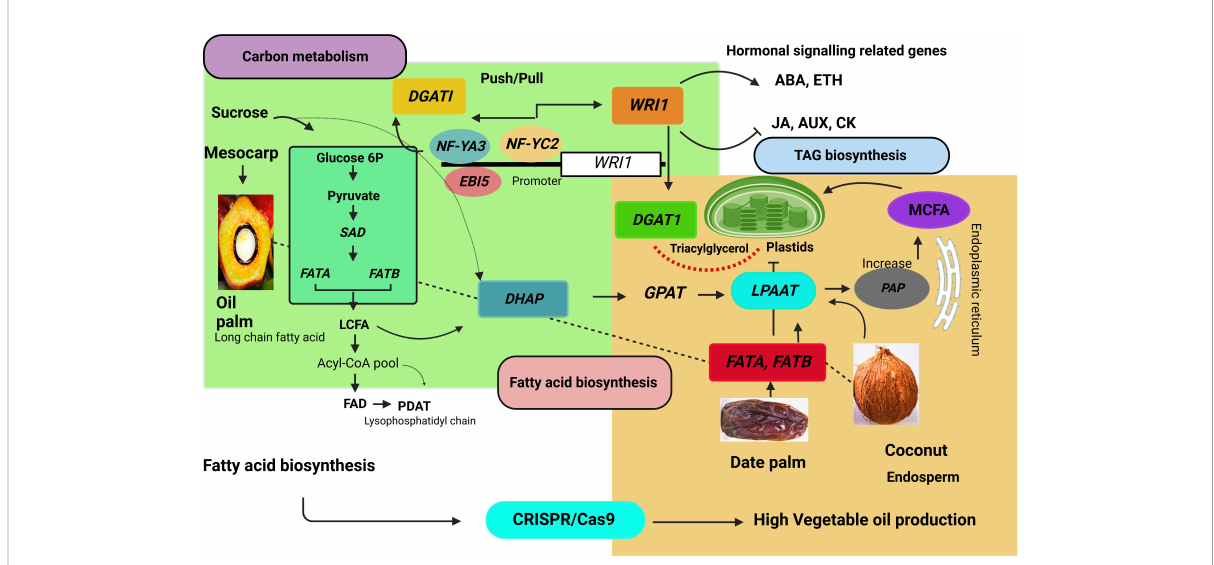
FIGURE 6 Fatty acid biosynthesis pathway in the palm tree. DGAT1 , diacylglycerol acyltransferase 1 ; WRI1, WRINKLED ; MCFA, medium chain fatty acid; LCFA, Long-chain fatty acid, LPAAT , lysophosphatidic acid acyltransferase ; FATA , acyl-CoA thioesterase A ; FATB , acyl-CoA thioesterase B ; EBI5 , ABA INSENTIVE 5 ; NF-YA3 , NUCLEAR FACTOR Y subunit A3 ; NF-YC2, NUCLEAR FACTOR Y subunit C2 ; WRKY40 , WRKY transcription factor 40 ; WRKY2 , WRKY transcription factor 2 . SAD, stearoyl-CoA 9-desaturase ; FAD , fatty acid desaturase; PDAT, phospholipids diacyleglycerol transferase; GPAT, glycerol-3-phosphate; PAP , phosphatic acid